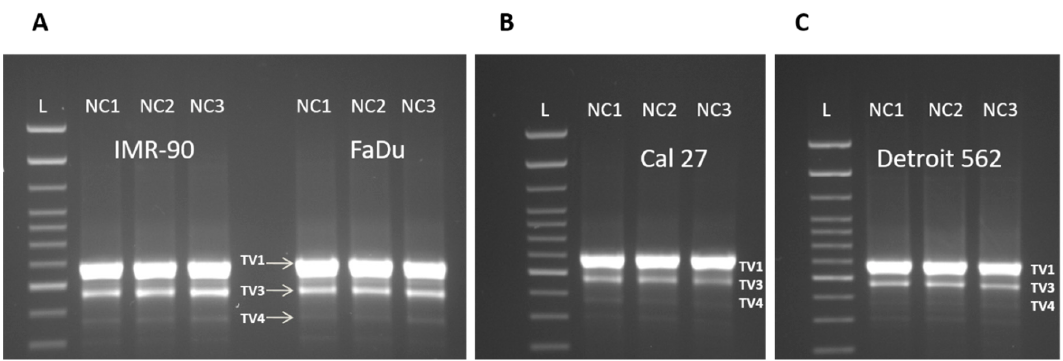
Figure 4. The presence of three NQO1 splice variants in all four cell lines, under three nutritional conditions (35 PCR cycles). L: 100 bp DNA ladder (Invitrogen). A . IMR-90 and FaDu; B . Cal 27; C . Detroit 562. TV1: 685 bps, TV3: 571 bps and TV4: 469 bps.